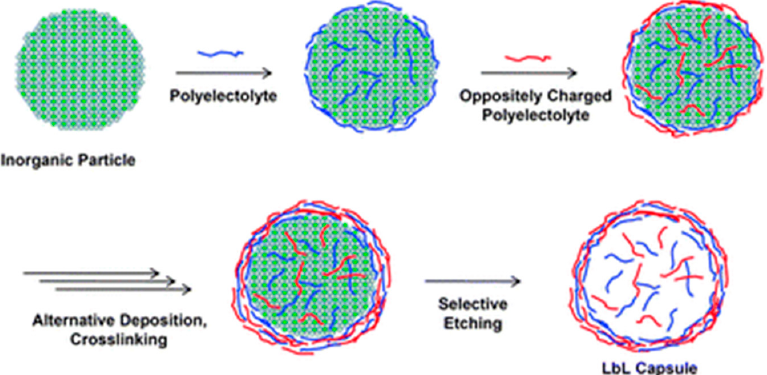
Figure 3. Formation of polyelectrolyte based layer-by-layer nanocapsule as schematized by Yoon et al. [50]. Reprinted with permission from [50]. Copyright 2010 Royal Society of